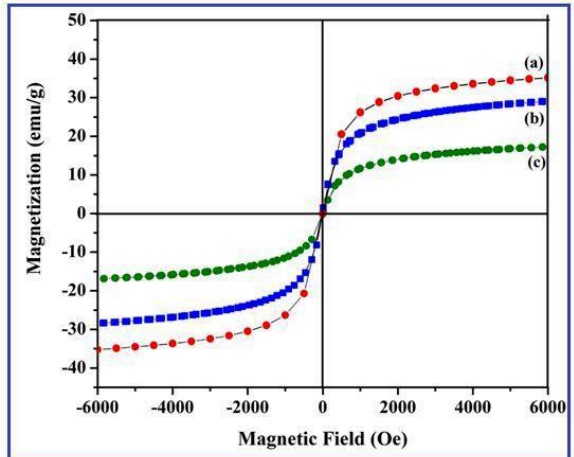
Figure 6. Magnetic measurements of γ-Fe 2 O 3 nanostructures synthesized using different % (1%, 2%